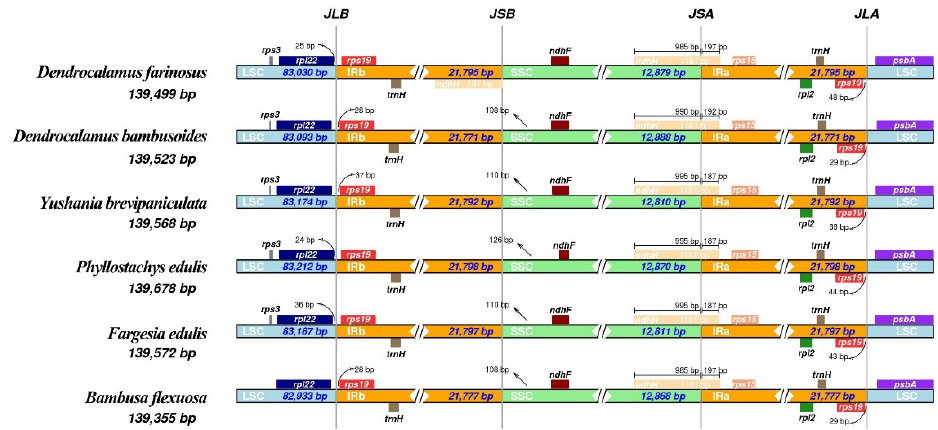
Figure 6. Comparison of the borders of the SSC, LSC, IRa and IRb regions among six cp genomes of Bambusoideae. JLB: junction of the LSC and the IRb. JSB: junction of the SSC and the IRb. JSA: junction of the SSC and the IRa. JLA: junction of the LSC and the IRa.